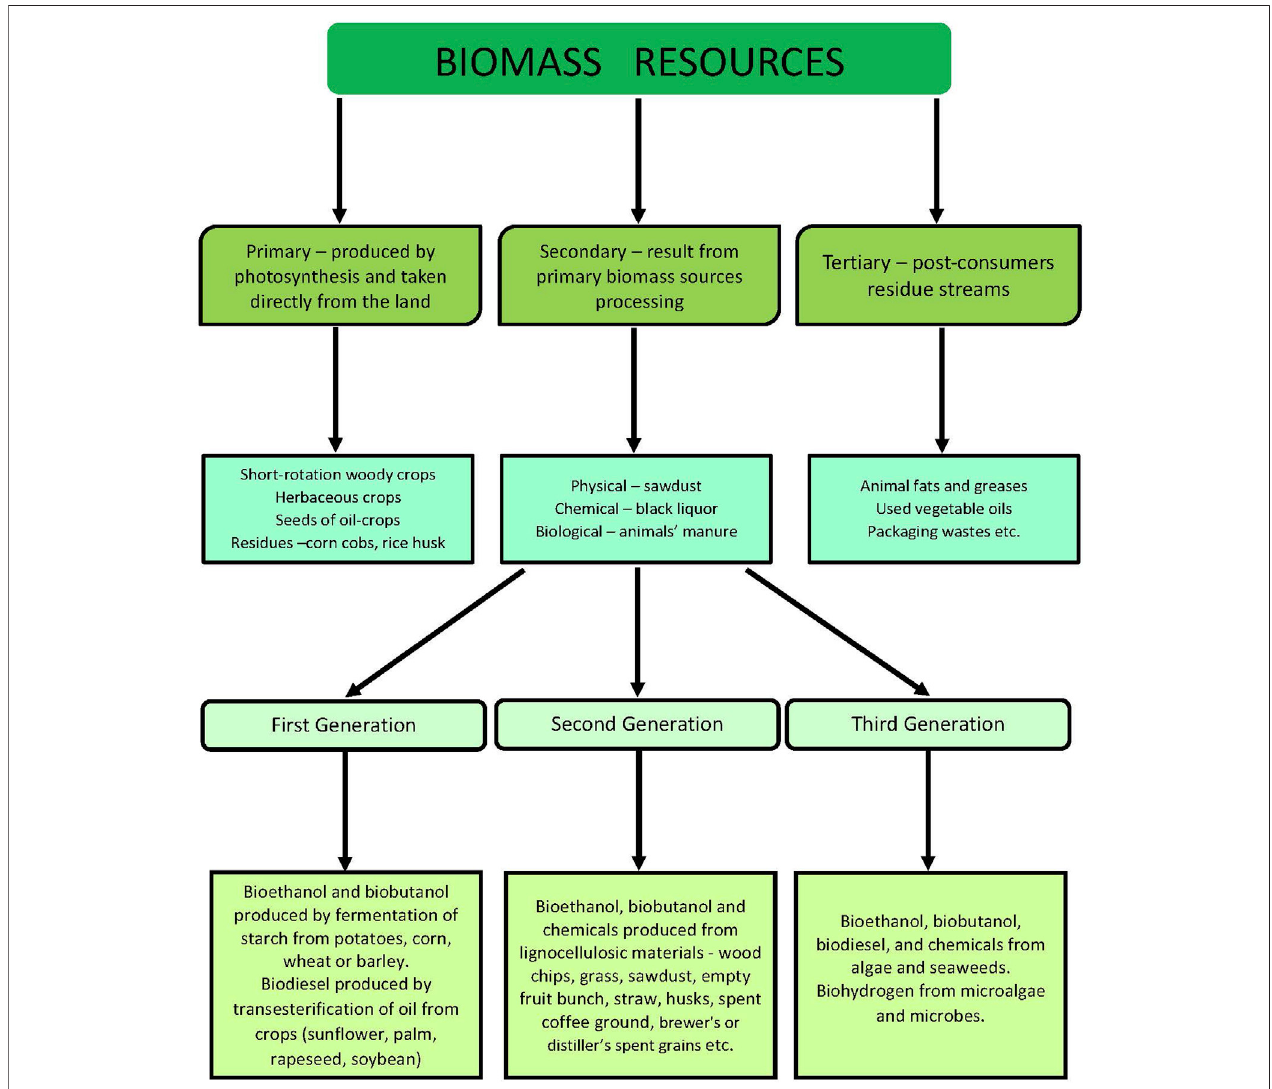
FIGURE 3 | Classi fi cation of biomass